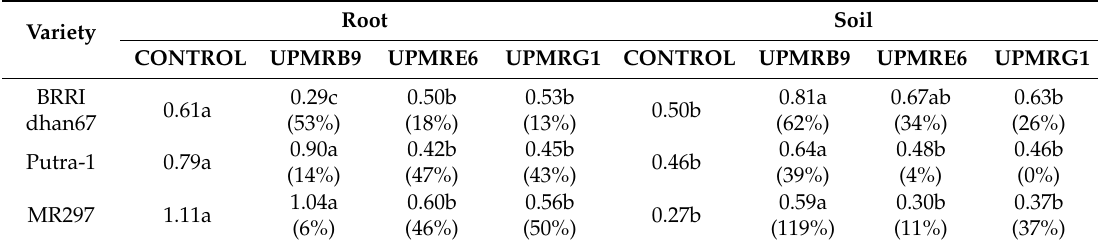
Table 3. E ff ect of bacterial inoculation on the Na / K ratio (% decrease / increase) in the below-ground parts (roots and soil) of three rice varieties under saline